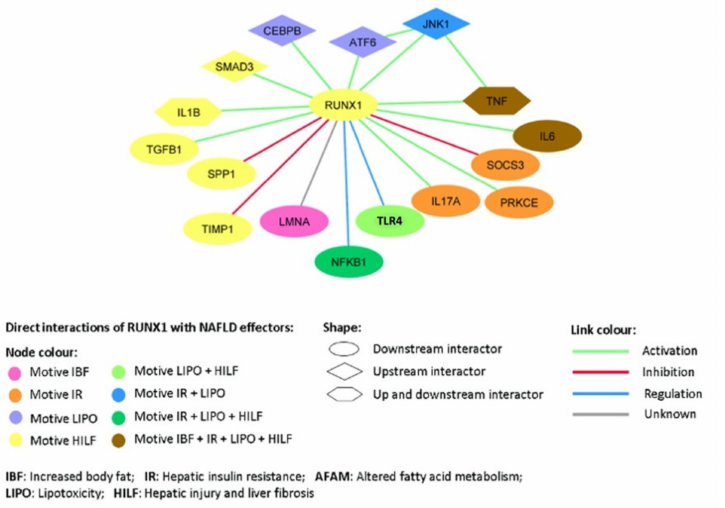
Figure 1. NAFLD effector proteins interacting with RUNX1 at distance 1 (direct link). RUNX1, runt-related protein 1; CEBPB, CCAAT/enhancer-binding protein beta; ATF-6, AMP-dependent transcription factor 6; JNK1, c-Jun N-terminal kinase 1; TNF, tumour necrosis factor; IL6, interleukin 6; SOCS3, suppressor of cytokine signaling 3; PKCE, protein kinase C epsilon type; IL17A, interleukin 17A; TLR4, toll-like receptor 4; NFKB1, nuclear factor kappa B 1; LMNA, lamin-A/C; TIMP1, metallo- proteinase inhibitor 1; SPP1, secreted phosphoprotein 1; TFGB1, transforming growth factor beta-1 proprotein; IL1B, interleukin 1 beta; SMAD3, mothers against decapentaplegic homolog